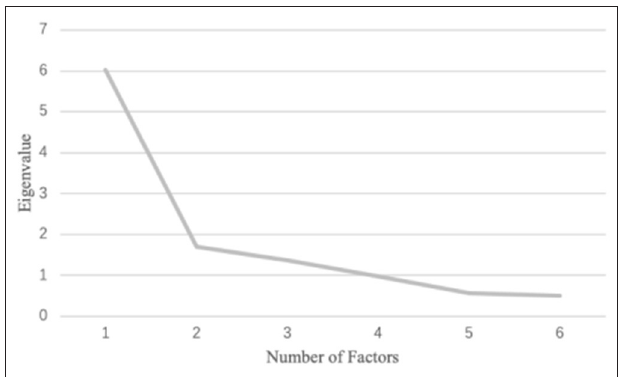
FIGURE 2 | Screen plot for the second exploratory factor analysis with 13